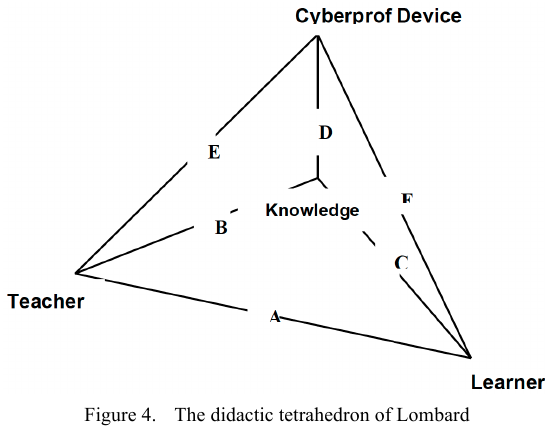
Figure 3. The Didactic Triangle of HOUSSAYE